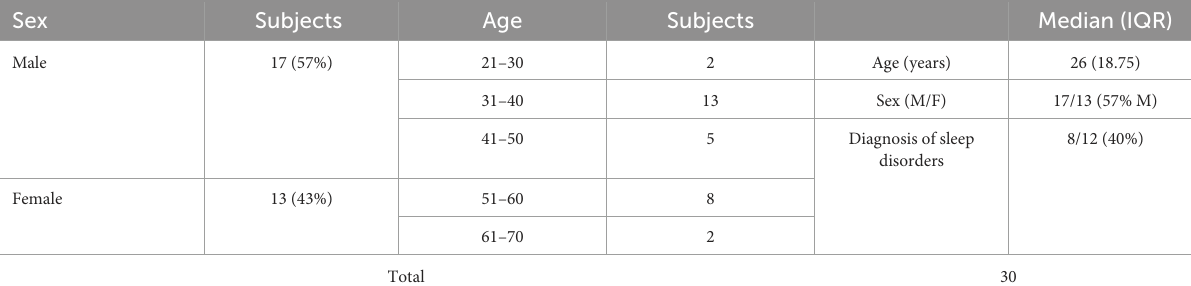
TABLE 2 Demographic information of 30 subjects.